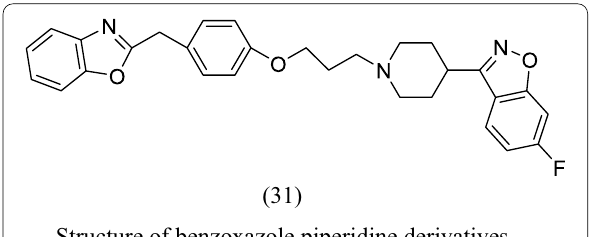
Fig. 34 Structure of benzoxazole piperidine derivatives